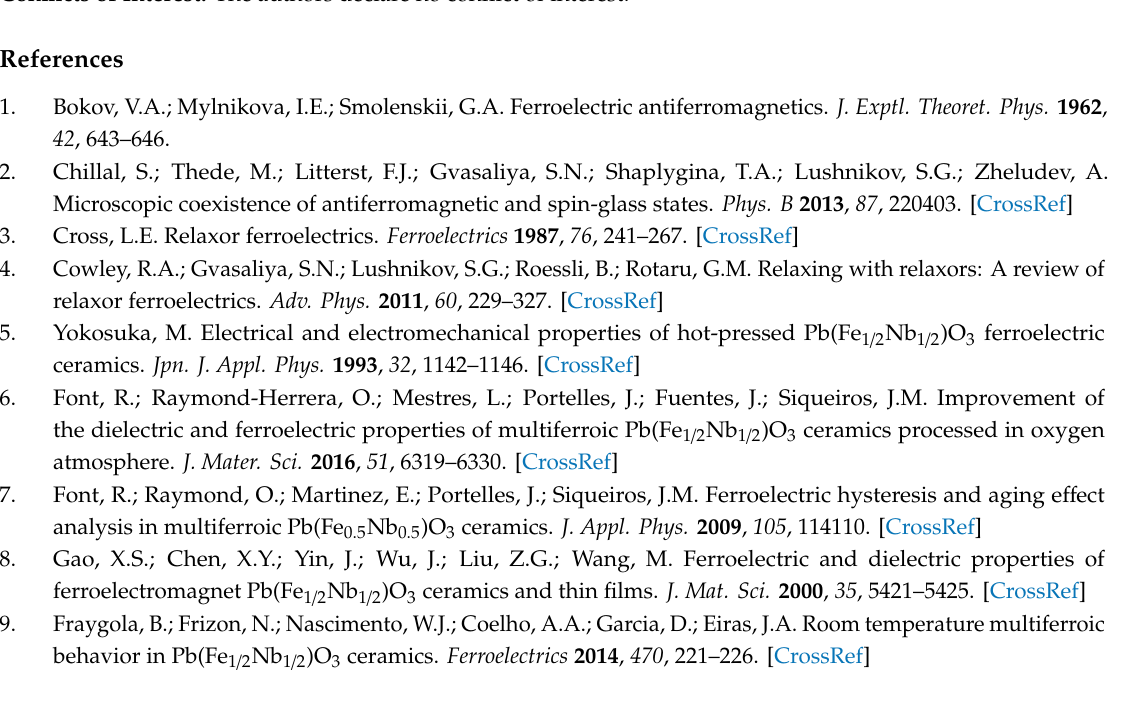
Figure S1: FE-SEM micrographs of (a) polished and (b) fractured surface, Figure S2: STEM image of grains in PFN sample, sintered at 1000 ◦ C with the corresponding EDXS elemental maps showing chemically homogenous polycrystalline sample without secondary phases, Figure S3: XRD profiles of the (200), (220), and (222) pseudocubic reflections (corresponding only to Cu K α 1) for PFN obtained after Rietveld refinement of the room-temperature XRD data, considering the (a) Cm, (b) R3mR, and (c) P4mm space groups. The black dots represent the observed data, the red line is the calculated profile, and the grey bottom line is the di ff erence between the calculated and experimental (observed) profiles. The marked 2 θ positions show the allowed Bragg peaks, Figure S4: The observed (dots), calculated (red line), and di ff erence (grey bottom line) profiles obtained after Rietveld refinement of PFN using the monoclinic Cm space group. The marked 2 θ positions below the profile show the allowed Bragg peaks for Cu K α 1, Table S1: Refined structural parameters for PFN using di ff erent space groups: Cm, R 3 mR , and P 4